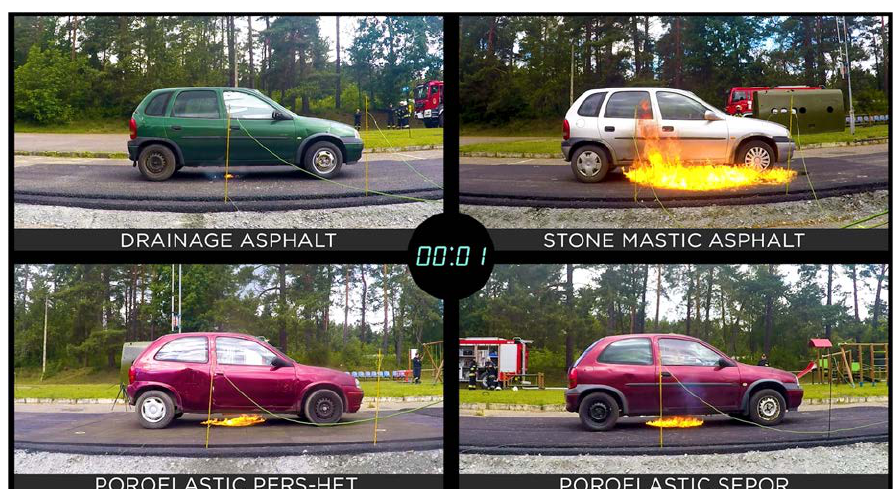
Figure 38. Development of fire 1 s after ignition. Materials 2017 , 10 , x FOR PEER REVIEW